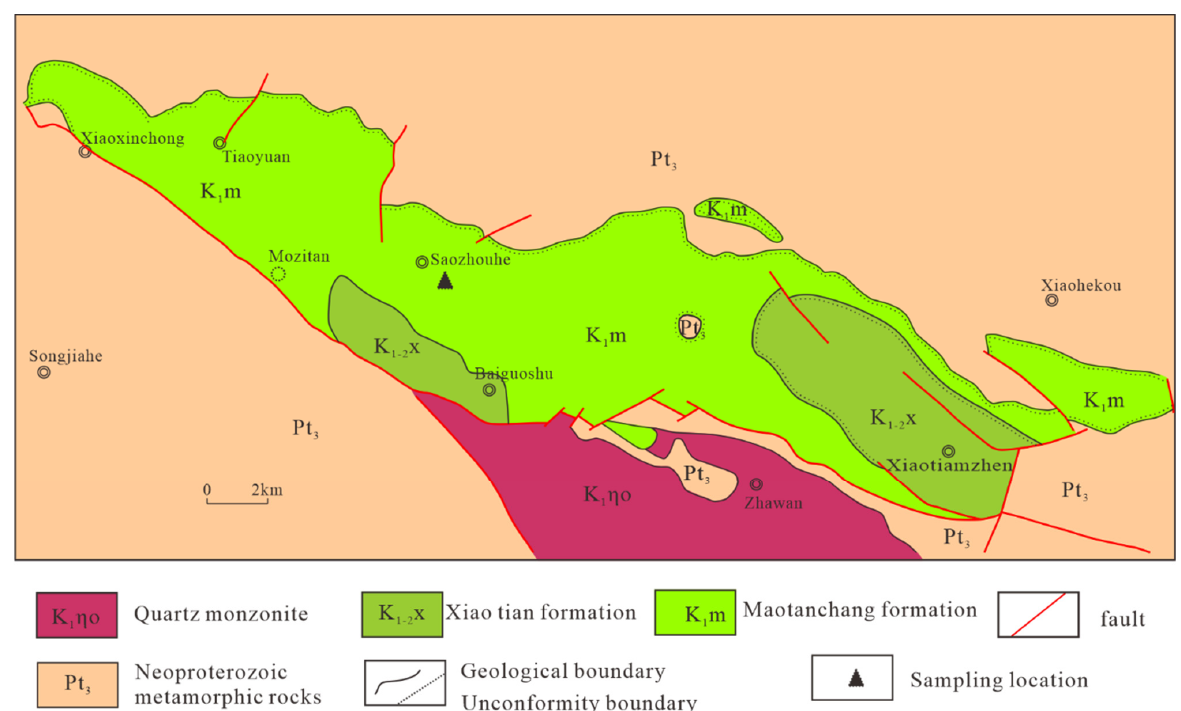
Figure 2. Geological sketch map of the Xiaotian Basin.